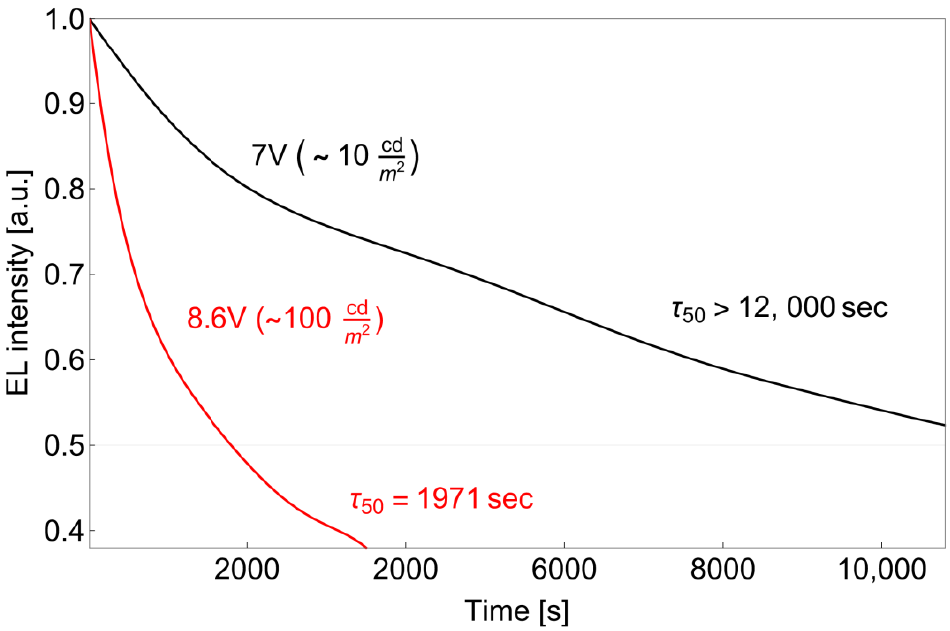
Figure 6. Lifetime of solution-processed OLED based on Eu(dbm) 3 DPPZ under the constant voltage of 7 V (~10 cd/m 2 ) and 8.6 V (~100 cd/m 2 ).